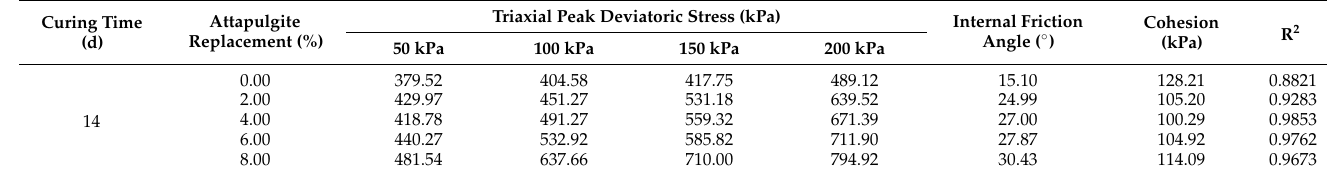
Table 3. Parameters of triaxial shear test results of attapulgite composite samples.